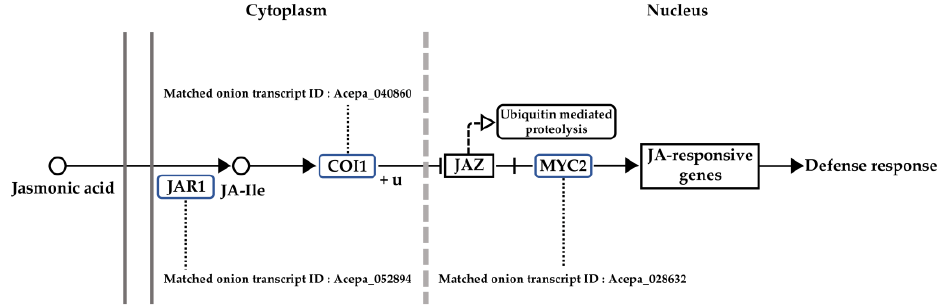
Figure 4. Matched onion transcripts to genes involved in the ‘plant hormone signal transduction: α -linolenic acid metabolism’ pathway. JAR1 : Jasmonate-resistant 1 , COI1 : Coronatine-insensitive protein 1 , MYC2 : transcription factor MYC2 .